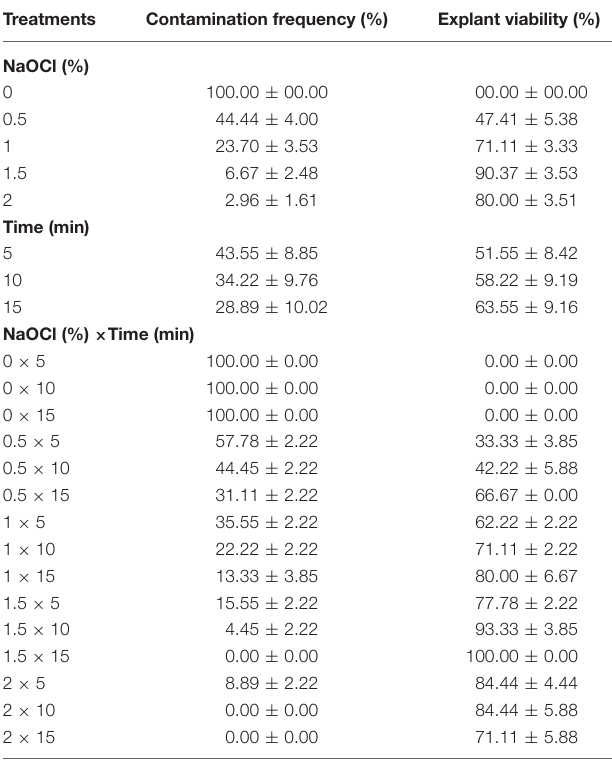
TABLE 1 | Effect of different concentrations of NaOCl at various immersion times on in vitro sterilization of chrysanthemum.